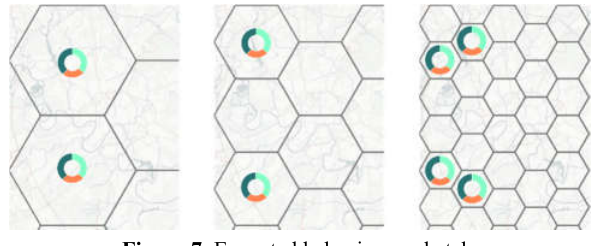
Figure 7 . Expected behaviour – sketch.